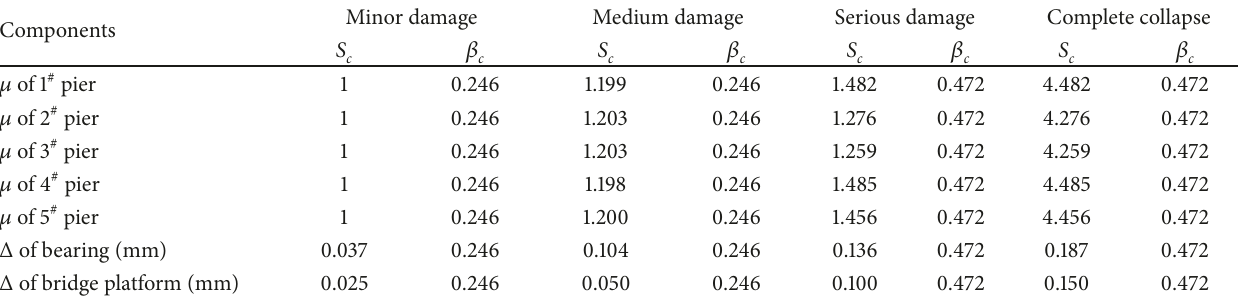
Table 8: Damage index and uncertainty of different bridge